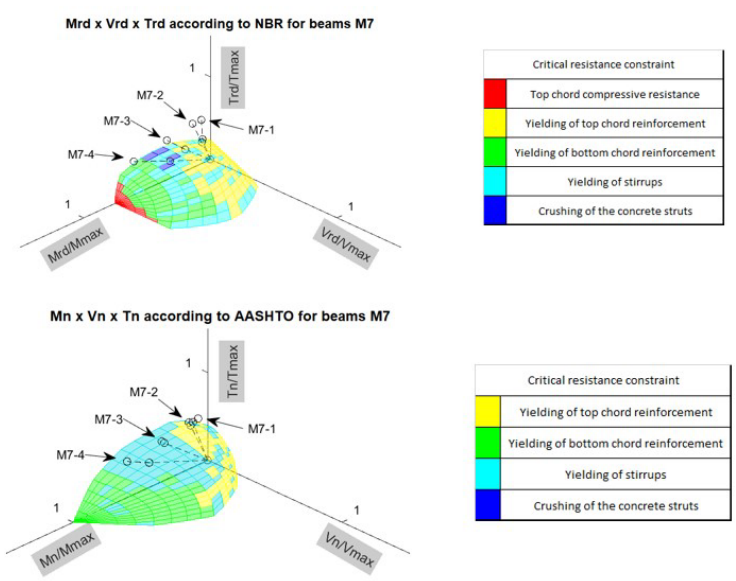
Figure 23: Interaction surface according to NBR and AASHTO for beams